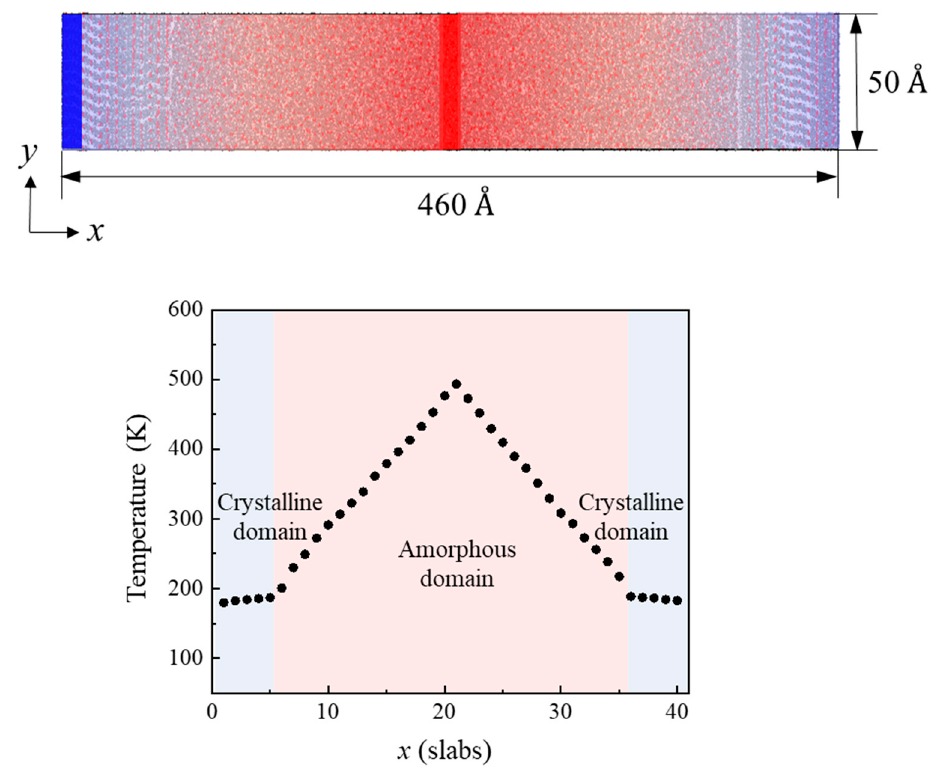
Figure 2. Temperature gradient of a semi-crystalline PEEK model during RNEMD simulation.